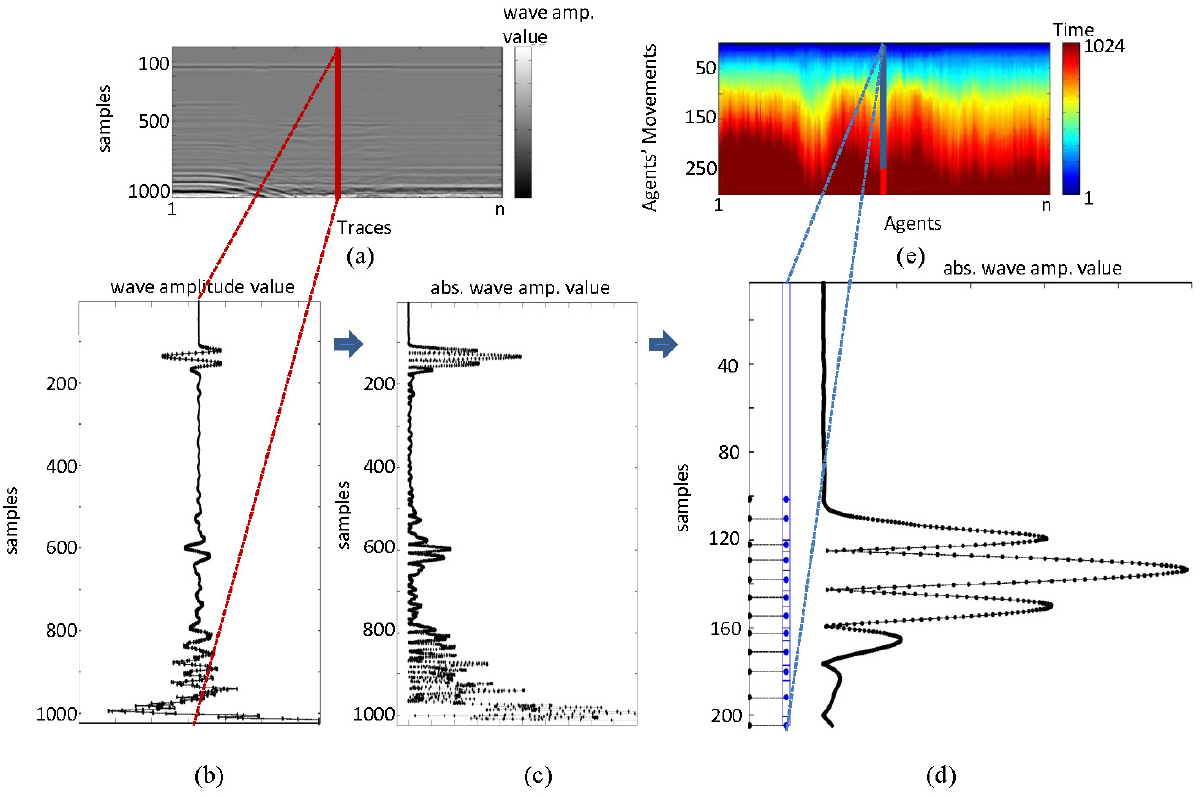
Figure 9. Principles of the ground penetrating radar (GPR) image